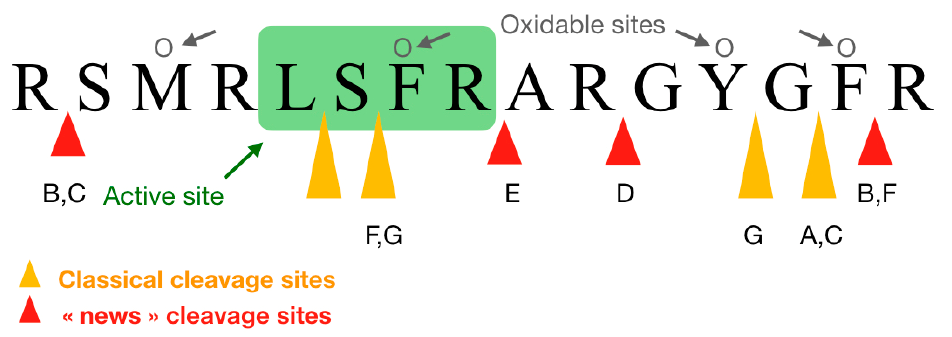
Figure 4. Peptides derived from CTL. sequence of L/D-CTL, and specific cleavage sites producing released fragments.